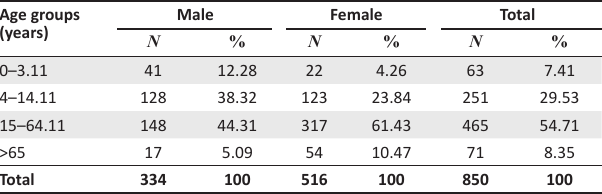
TABLE 1: Distribution of participants by age and gender ( n = 850). Age groups